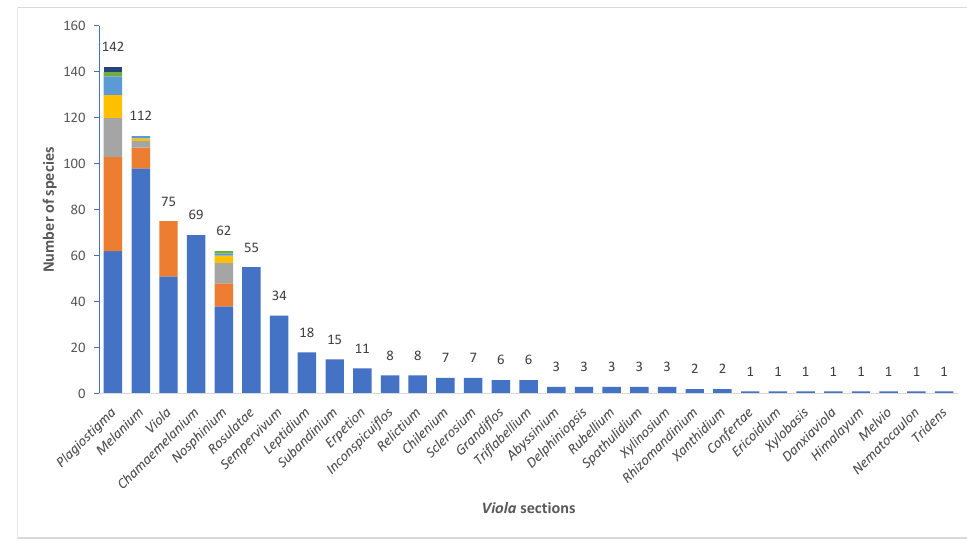
Figure 4. Stacked bar plot showing species richness among the 31 sections of Viola . Species counts are indicated above each bar. Sections containing subsections are indicated as stacked bars with the distribution of species among subsections indicated in different colours. For details on each subsection, see Table 1.